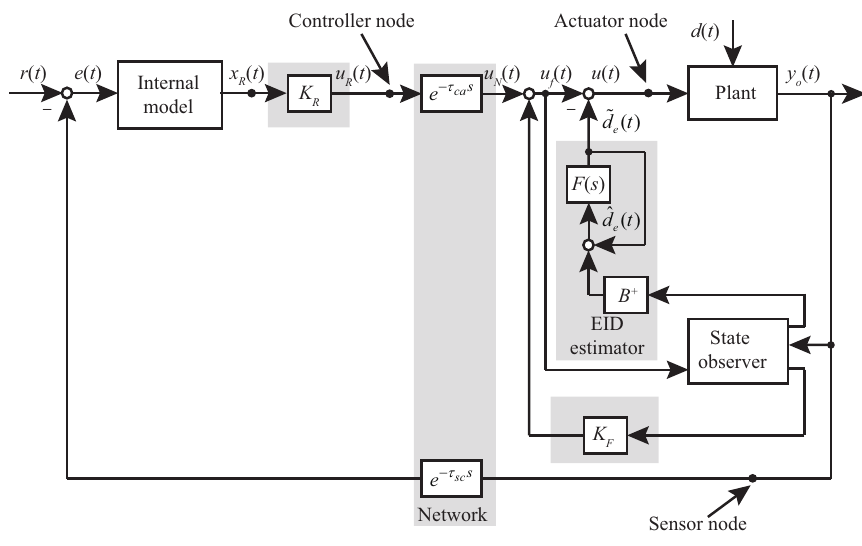
Figure 6. Configuration of EID-based NCS.